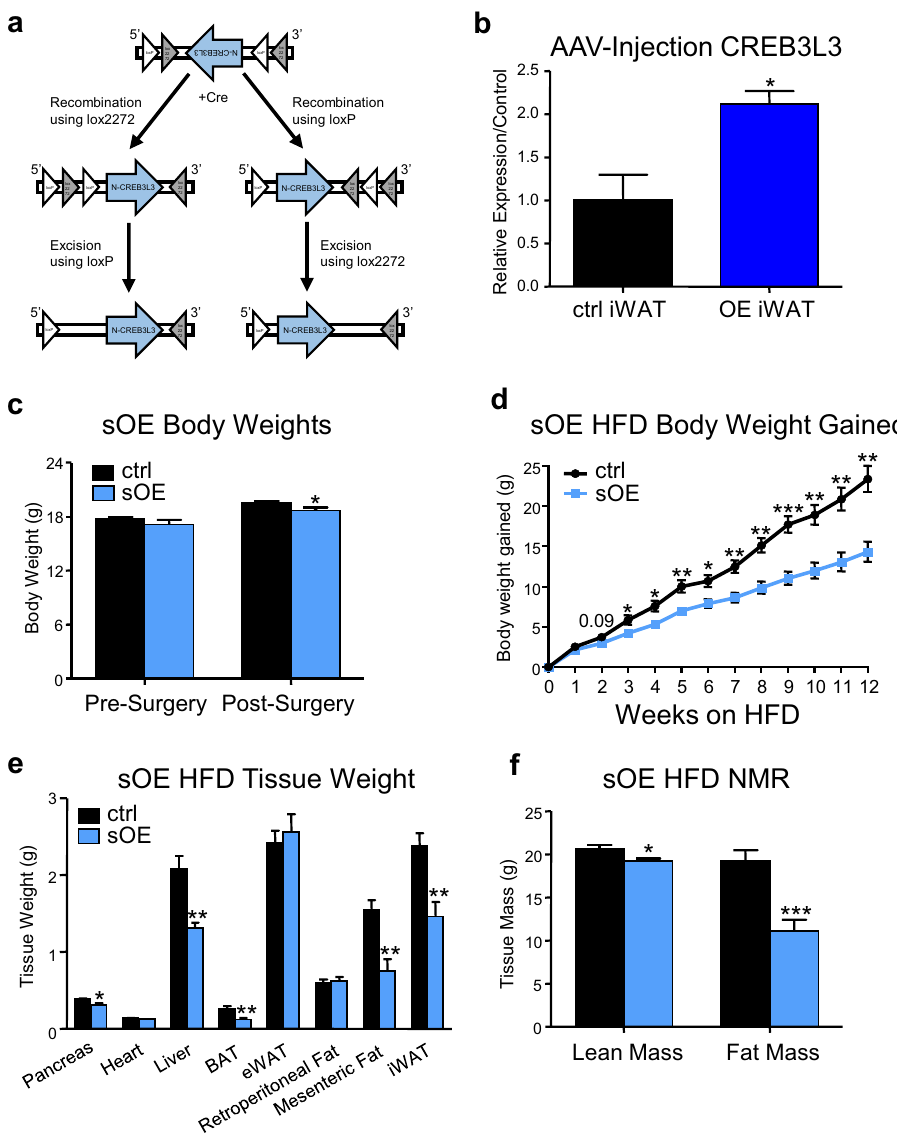
Figure 5. Increased expression of CREB3L3 in subcutaneous adipose tissue prevents diet-induced obesity. ( a ) Schematic depicting the recombination and inversion of CREB3L3 within the flip-excision (FLEx) AAV in the presence of Cre recombinase. ( b ) Quantitative PCR for the expression of CREB3L3 message in inguinal fat pads harvested two weeks following injection with the CREB3L3 FLEx AAV in Adiponectin-Cre (sOE) or littermates lacking the Cre BAC (ctrl) (n = 3–4 mice per group). CREB3L3 expression was normalized to TBP and presented as fold change over ctrl. ( c ) Body weight measurements of sham ctrl and sOE mice 2 wks after injection with the CREB3L3 FLEx AAV (n = 6–9 mice per group). ( d ) Measurements of the body weight gained by sham control and subcutaneous overexpression (sOE) mice after high-fat feeding (n = 6–9 mice per group). ( e )